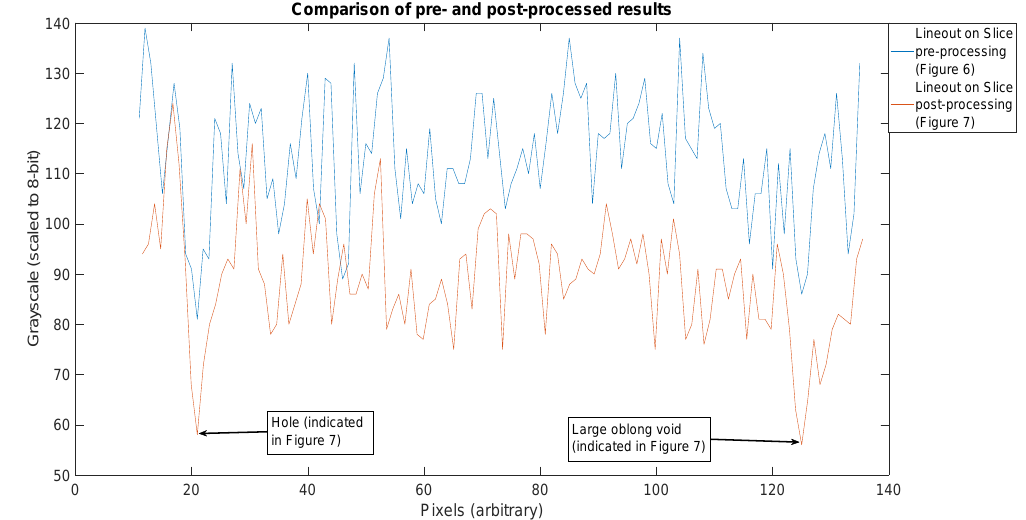
Figure 8. Lineout comparison done between the slice featuring a hard hit (Figure 6) and the slice post-processing (Figure